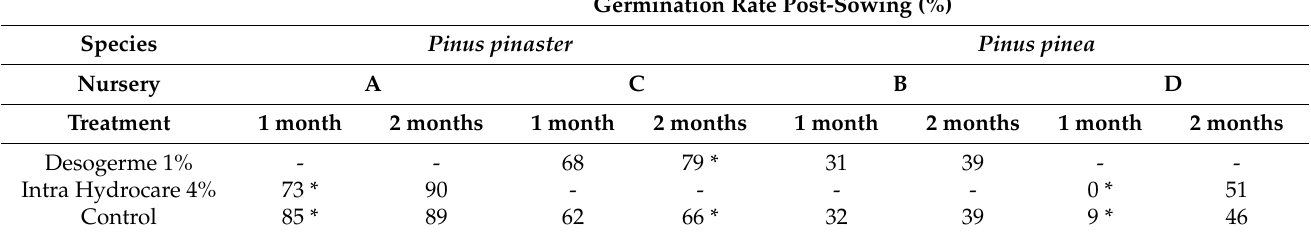
Table 4. Germination rate (%) after watering with the Desogerme 1% and Intra Hydracare 4% treatments in nurseries 1 and 2 months post-sowing. In each column, data followed by * were significantly different according to a t -test ( p <